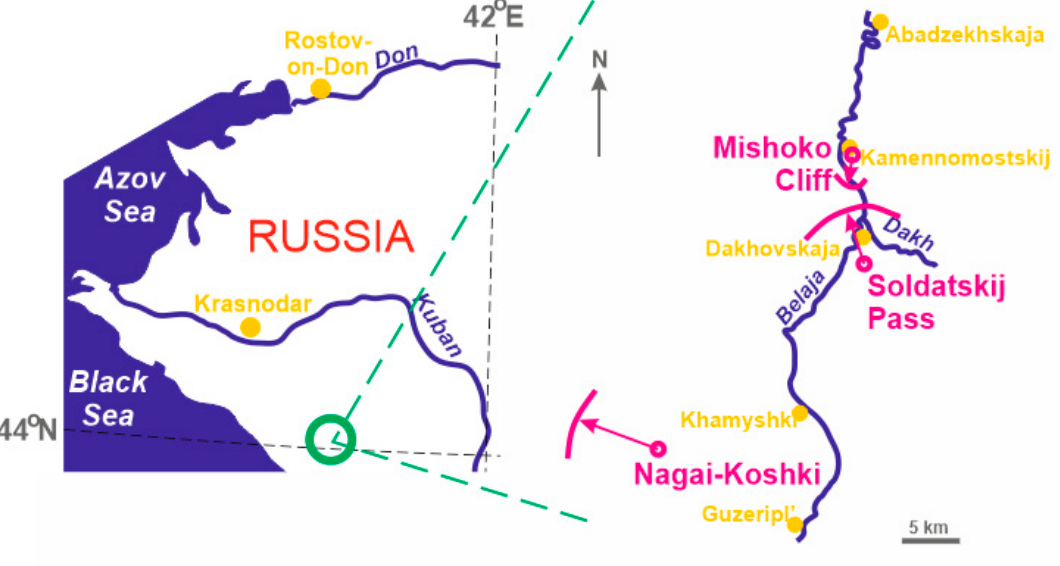
Figure 2. Location of the studied viewpoint geosites (arrows indicate directions of views in Figure 3); in each case, standpoint environment corresponds to circles, transition environment corresponds to arrows, and target environment corresponds to bold, violet lines.